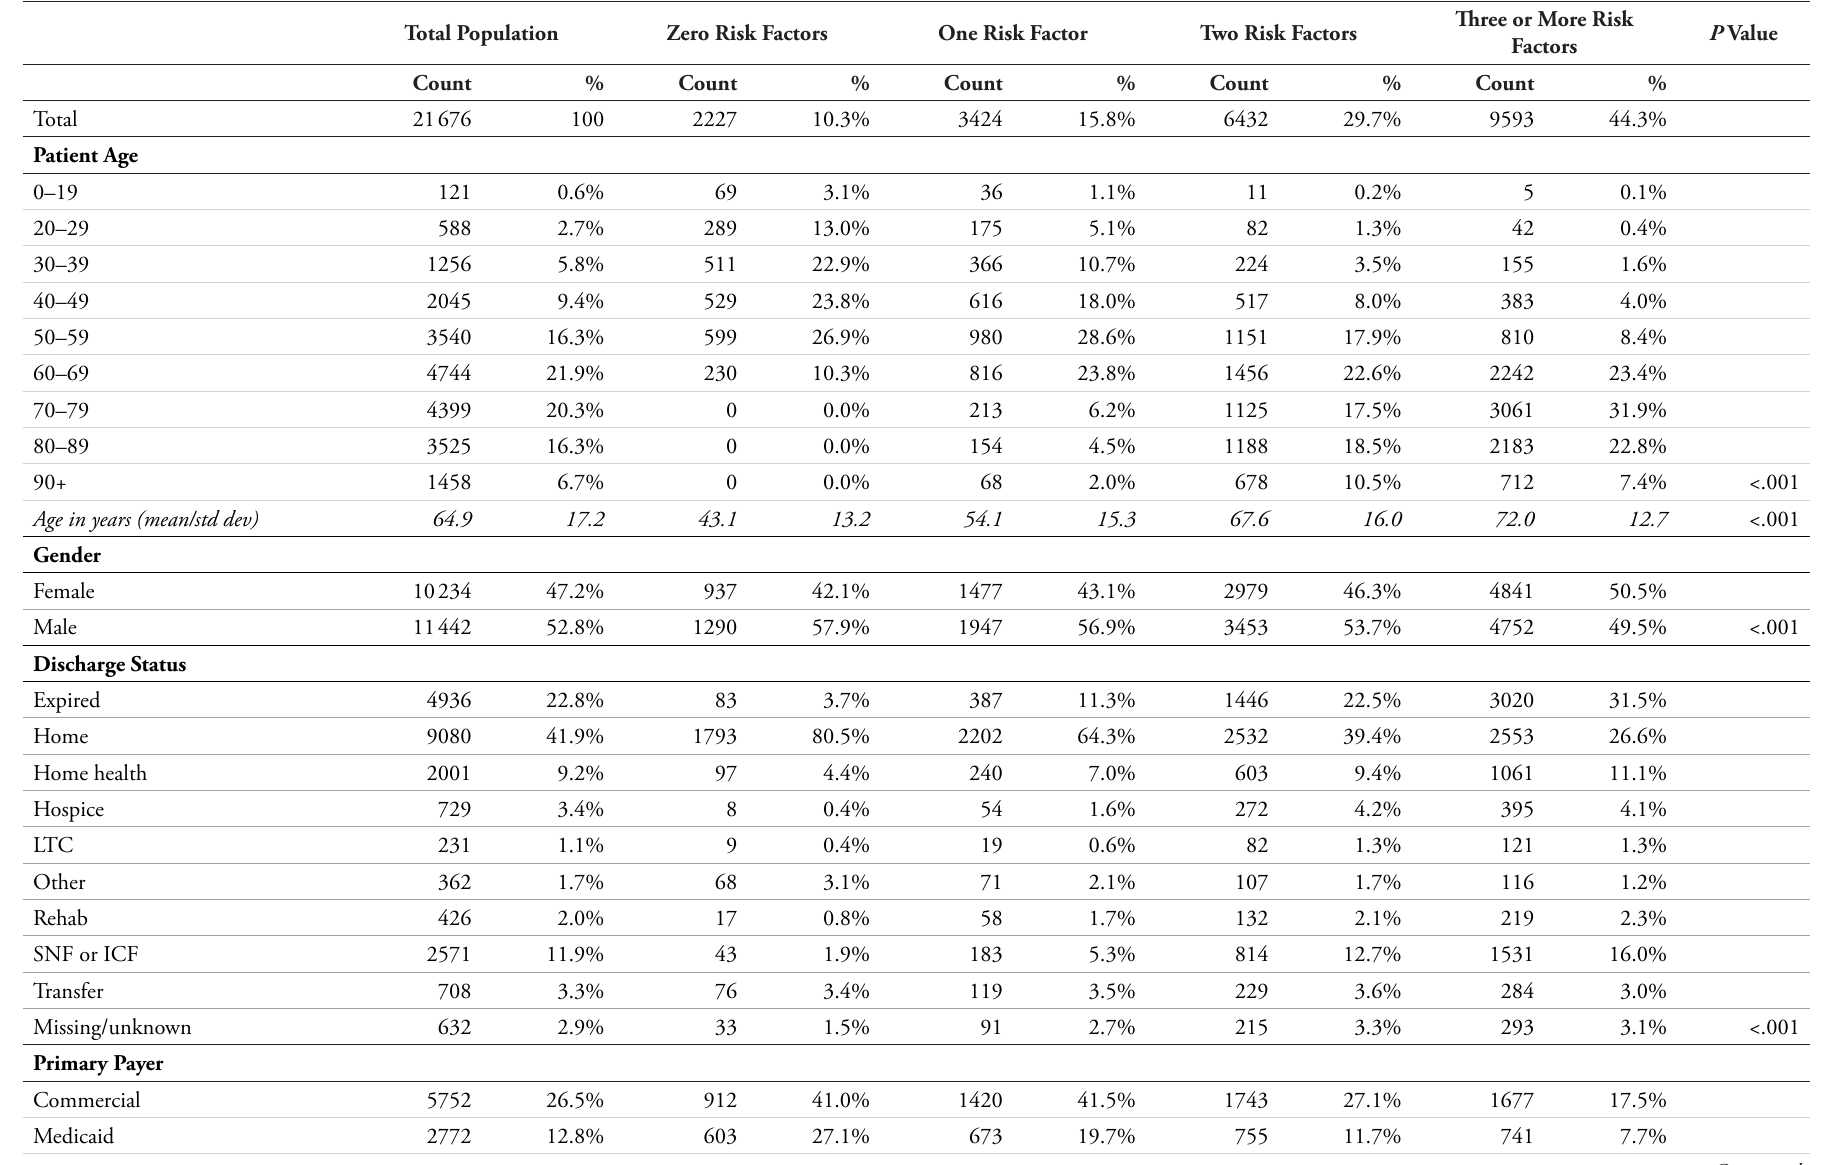
Table 1. COVID-19 Patient Characteristics by Number of Risk Factors Total Population Zero Risk Factors One Risk Factor Two Risk Factors